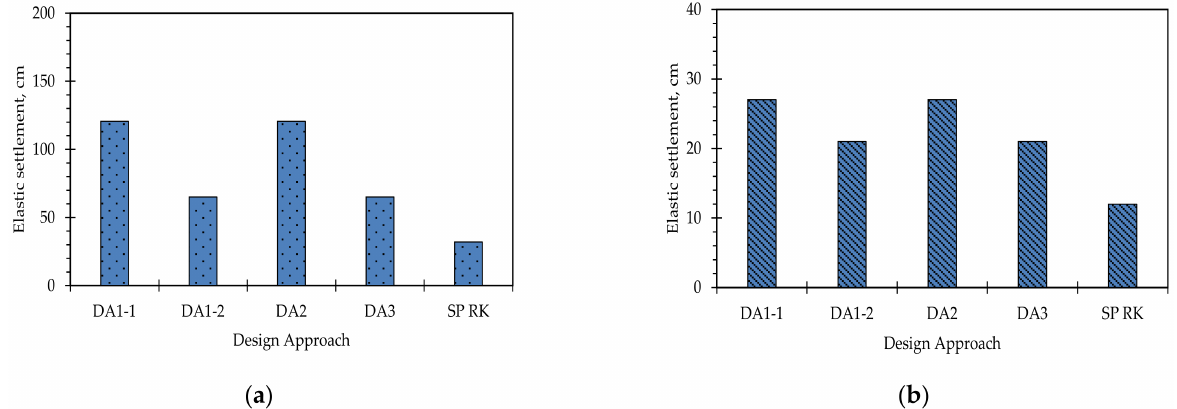
Figure 6. Elastic settlement values of the ( a ) raft foundation and ( b ) pile